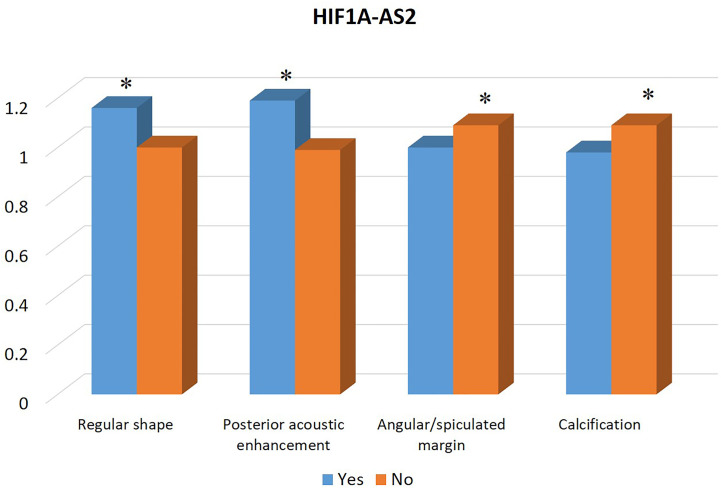
Association between the expression profile of lncRNA HIF1A-AS2 and sonographic features of TNBCs. The high expression of HIF1A-AS2 is significantly associated with benign sonographic features of regular shape, presence of posterior acoustic enhancement, absence of angular/spiculated margin, and no calcification. * indicates significant difference between the two groups with and without the specific sonographic feature.